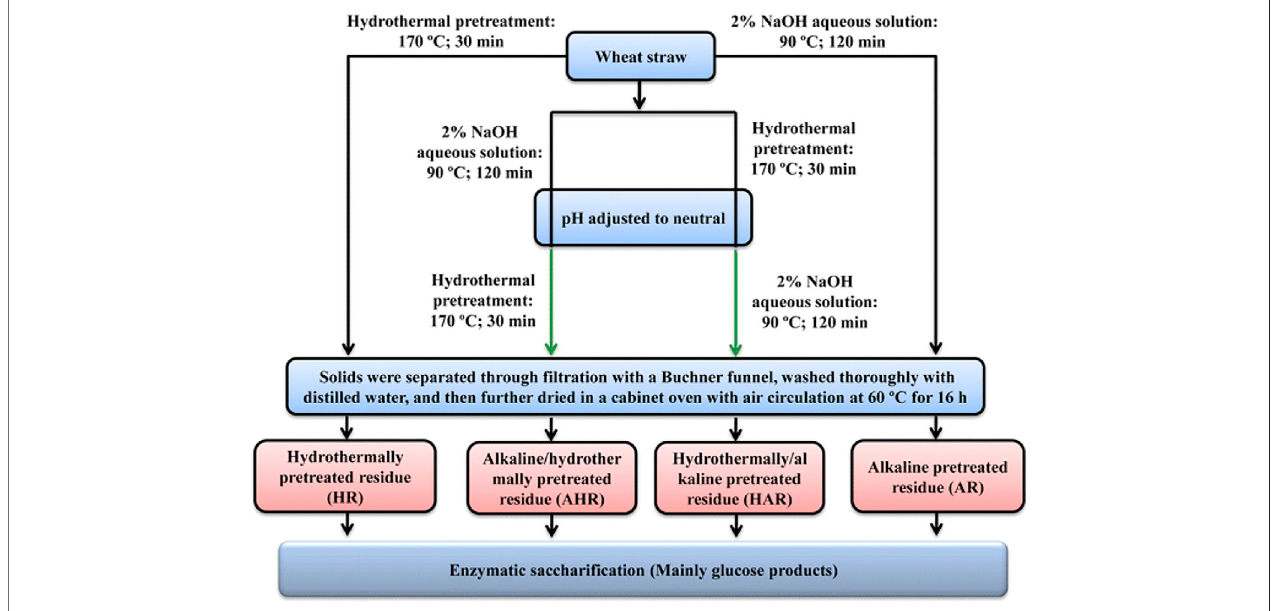
FIGURE 6 | Schematic illustration of one-step process based on hydrothermal and alkaline treatment (Sun et al., 2018).